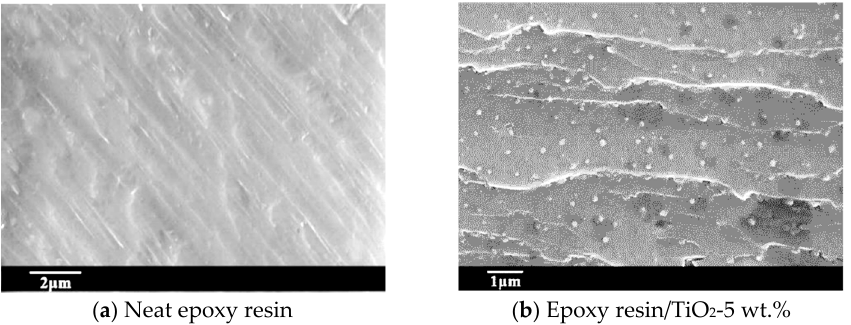
Figure 2. Micrograph of fracture surface of neat epoxy resin and its nanocomposite. ( a ) Neat epoxy resin; ( b ) Epoxy resin/TiO 2 -5 wt.%. resin; ( b ) Epoxy resin / TiO 2 -5